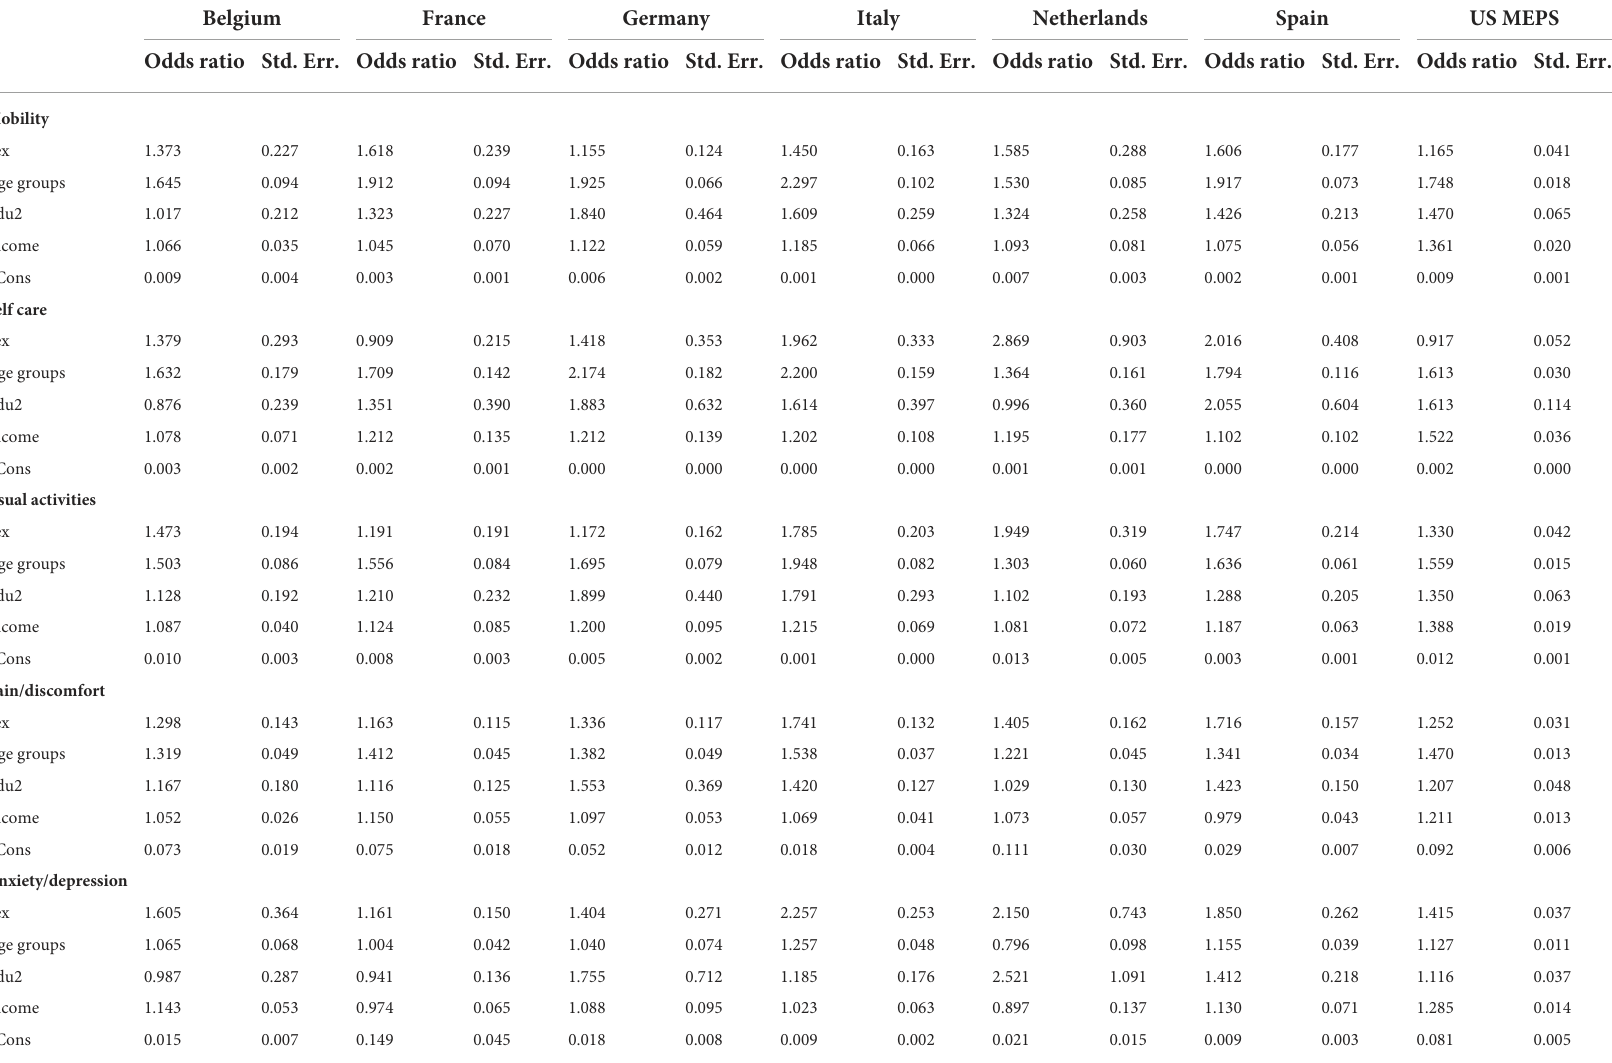
TABLE 4 Logistic regression odds ratios for reporting any problems on each EQ-5D-3L dimension in 7